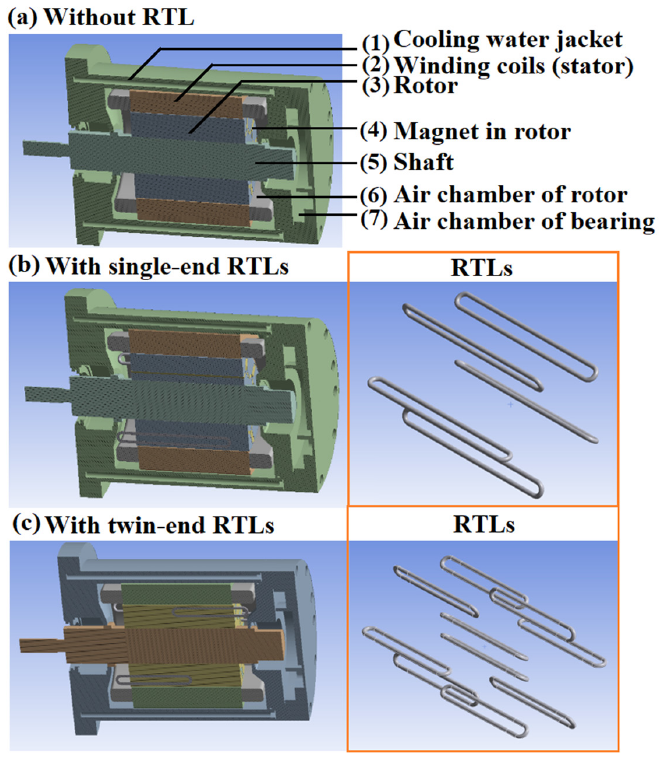
Figure 1. Constructions of the electric motors ( a ) without and with ( b ) single-end ( c ) twin-end thermosyphon loops in the rotor.